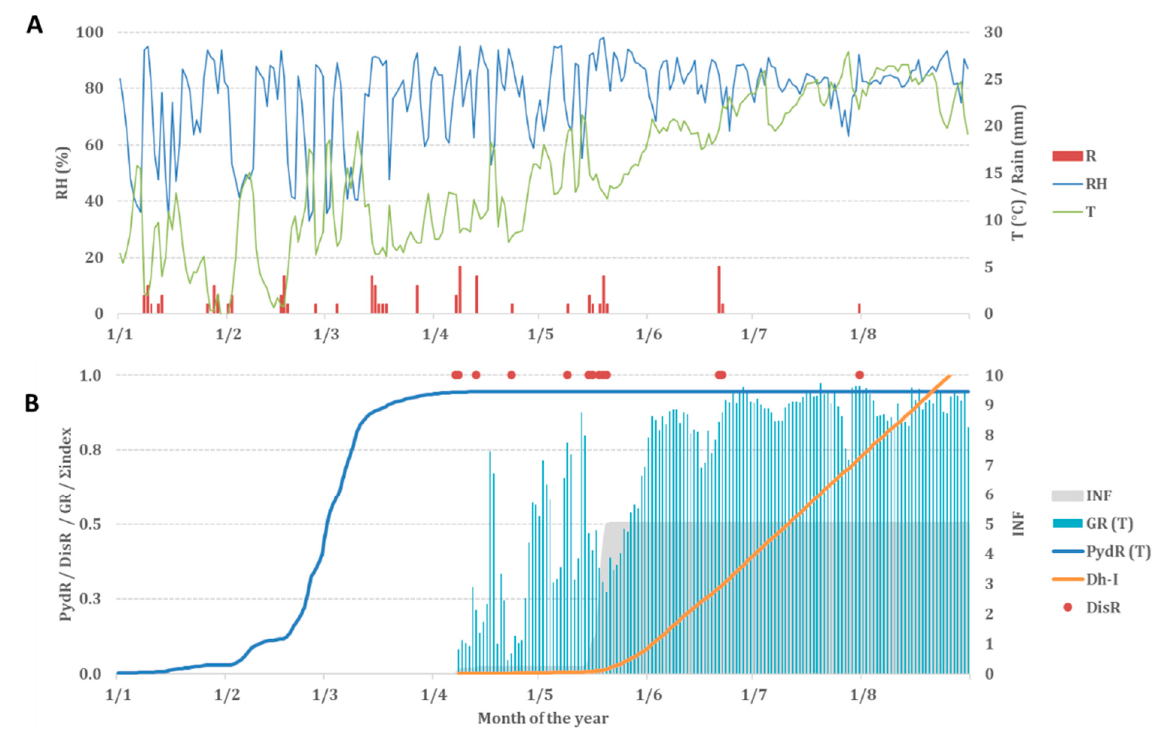
Figure 2. Example of DEFHAZ input and output in Georgia, 2016. ( A ) Weather data as input: air temperature (T) (green line in °C), rainfall (R) (red bars in mm), and relative humidity (RH) (blue line in %). ( B ) Trends of main model output: blue line (PydR (T)) is daily production rate of pycnidia, red dots (DisR) represent days when inoculum was dispersed, light blue bars (GR(T)) are D. eres growth rates, grey area is (INF) cumulative infection, and orange line ( Dh-I ) is cumulative infection index. Table 2. Parameter b and statistics of logistic regression (Equation (1)) applied to predict probability of having hidden and total defective hazelnuts ( ≥ 1%) as function of output index of predictive model in different considered